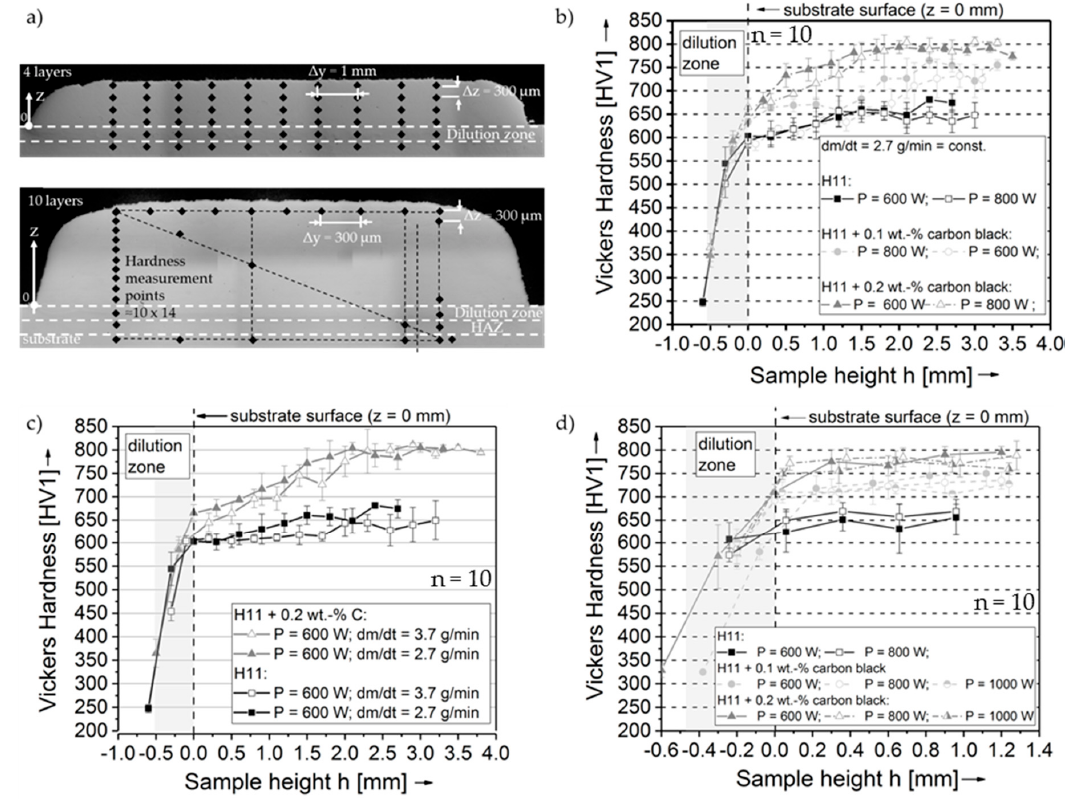
Figure 13. (a ) distribution of hardness measurement points over the cross section of four- and ten-layered sample (H11 + 0.2 wt. % carbon black: P = 600 W, m = 3.7 g/min); Hardness profiles of samples made out of the investigated tool steel powders as function of the sample height h with respect to laser power: ( b ) 10-layered samples at m = 2.7 g/min, ( c ) 10-layered samples with different powder mass flows and ( d ) 4-layered samples.